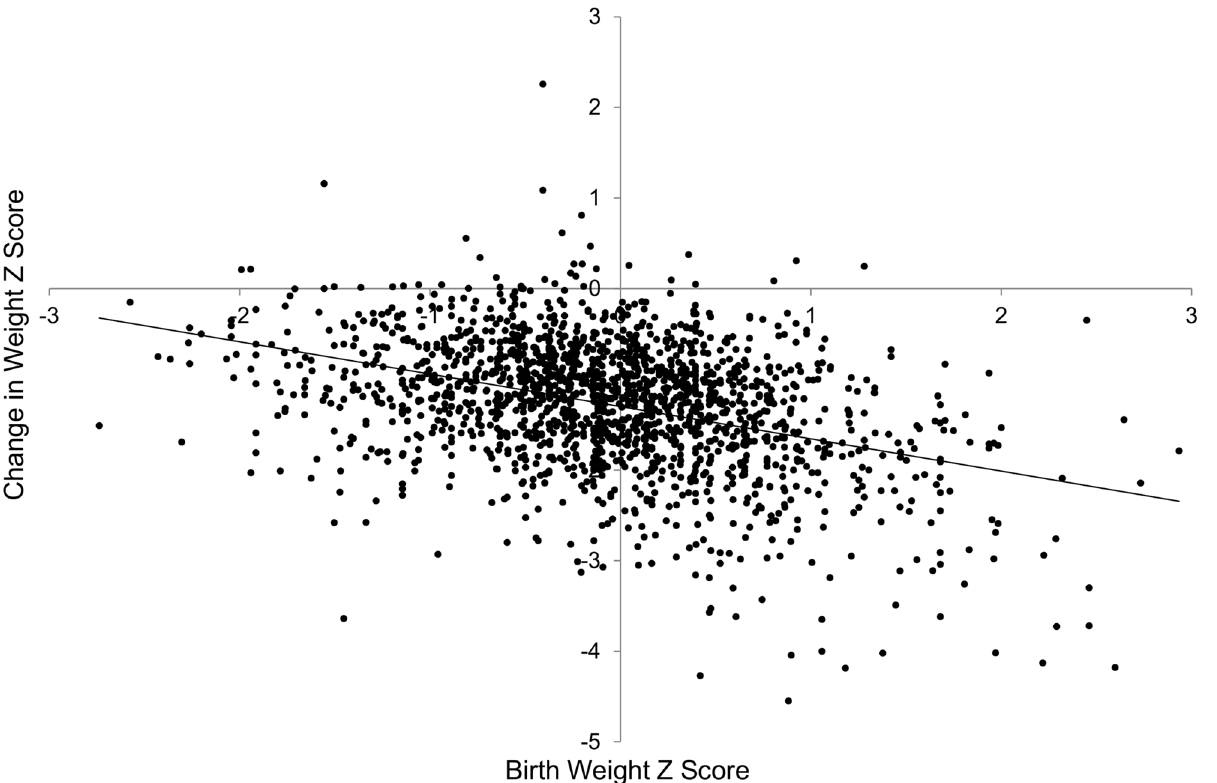
Fig 2. Change in weight Z score from birth to discharge vs. birth weight Z score for the reference NICU (Mount Sinai). Regression line: y = -0.387x- 0.980, R 2 = 0.192 (p <